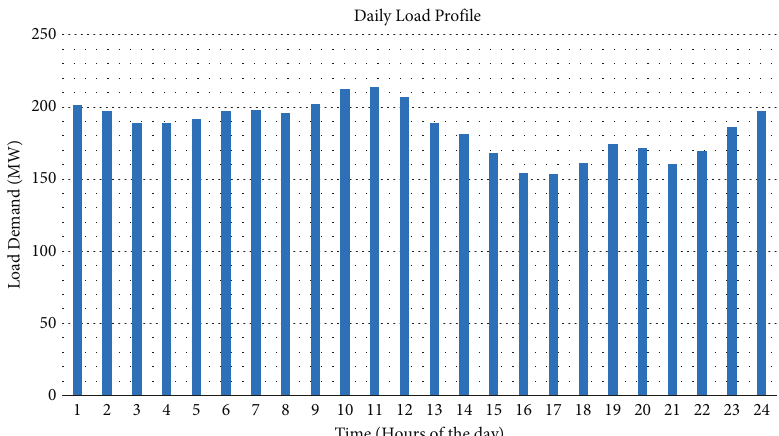
Figure 12: Average daily load demand profile.